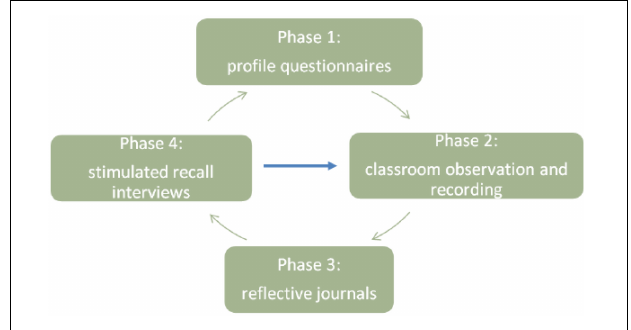
FIGURE 1 | The data collection